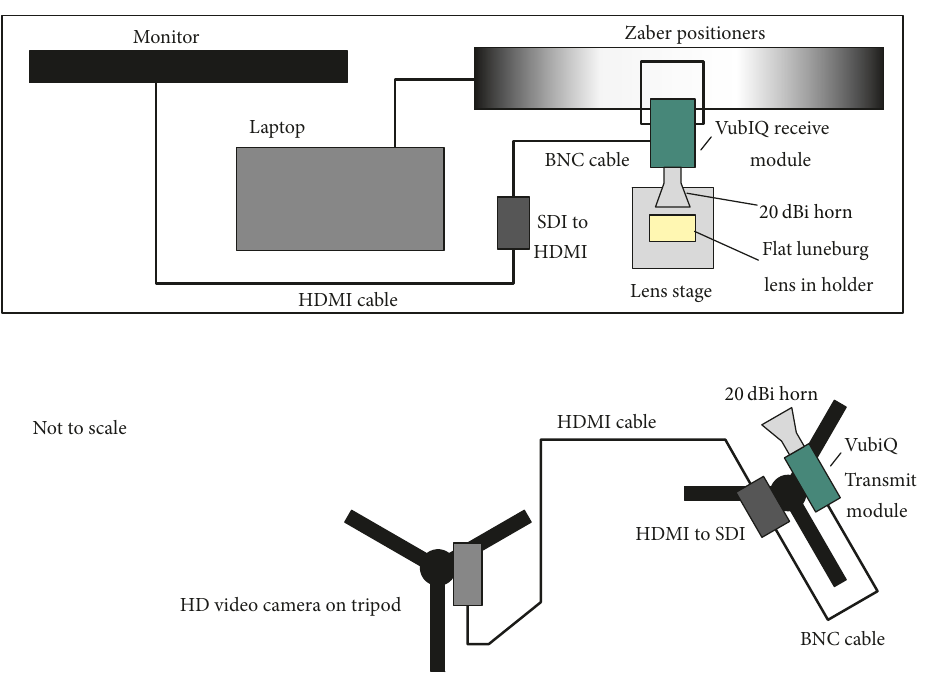
Figure 5: Sketch of the experimental arrangement for testing video transmission (plan